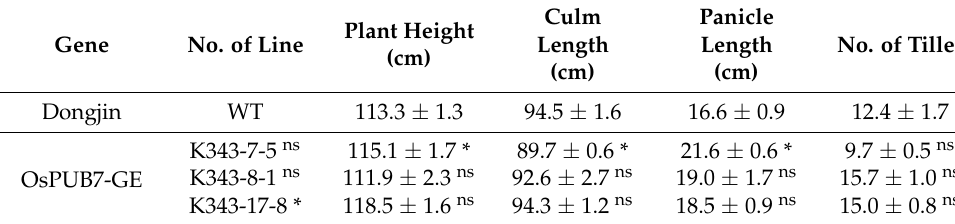
Table 3. Agronomic traits of PUB7-GE in the T 3 generation.